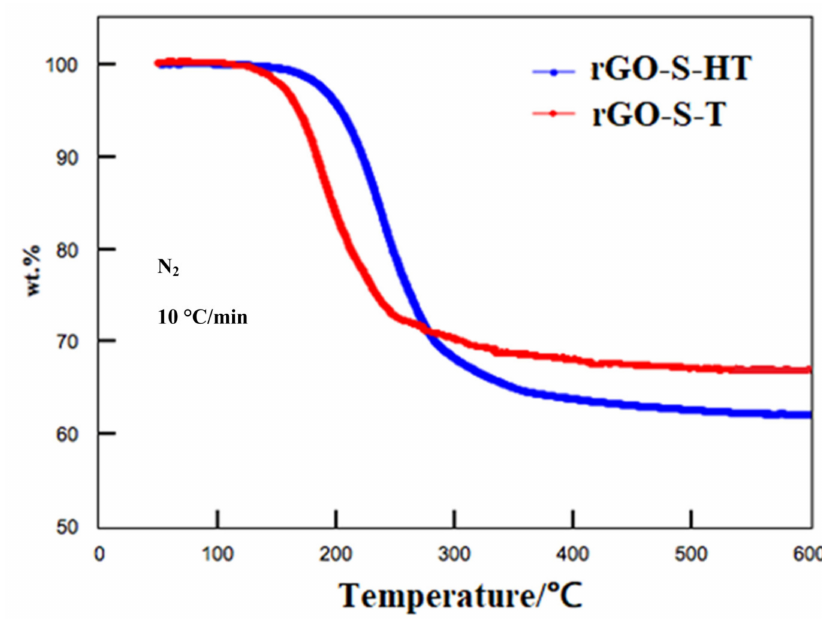
Figure 3. TGA curves of rGO-S-HT and rGO-S-T samples. The surface chemical compositions and functional groups of the rGO-S-HT and rGO- S-T were identified by XPS technique. Figure 4 presents the C1s and S 2p binding energy spectra of the two composite samples. The C1s exhibits one strong peak at about 284.0 eV for the rGO-S-HT. By further fitting, we can split the strong peak into three peaks 283.5, 284.1, and 285.2 eV, respectively, which are assigned to C–C, C–S, and C=O (Figure 4a). As for the rGO-S-T (Figure 4b), the C1s possesses one strong peak and a shou1der weak located at around 284.0 eV and at 285.0 eV, respectively, which suggests the existence of C-O bonding in rGO-S-T [45,46]. The S 2p has one strong peak of around 163.0 eV and a broad peak of 164.2 eV both for the two rGO-S composite samples (Figure 4c,d). While for the binding energy of S2p 3/2 peak, it is located at 162.9 eV for the two rGO-S composite samples, lower than the value of elemental S (164.0 eV), which reveals the existence of the chemical bonding between S and rGO. After further fitting, the peak at 163.5 eV can be attributed to the S–O bonds, and the peak at 164.2 eV may be ascribed to the sulphate species formed from sulfur oxidation between S and oxygen functional groups of GO